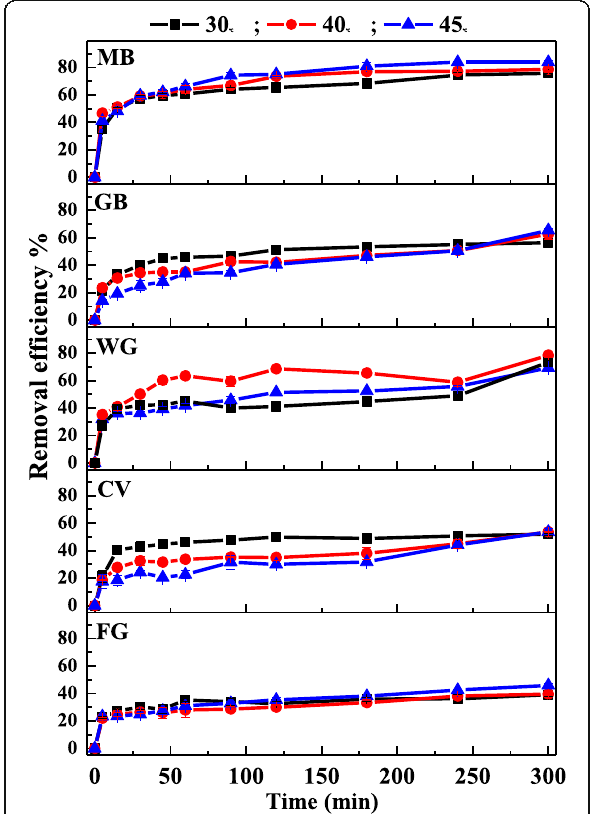
Fig. 6 Effect of temperature on the adsorption of cationic dyes on Fe 3 O 4 /PCC MNPs. As shown as Fig. 6, the blank line represent that the temperature is 30 °C, the red line reperesent that the temperature is 40 °C, and the blue line represent the temperature is 45